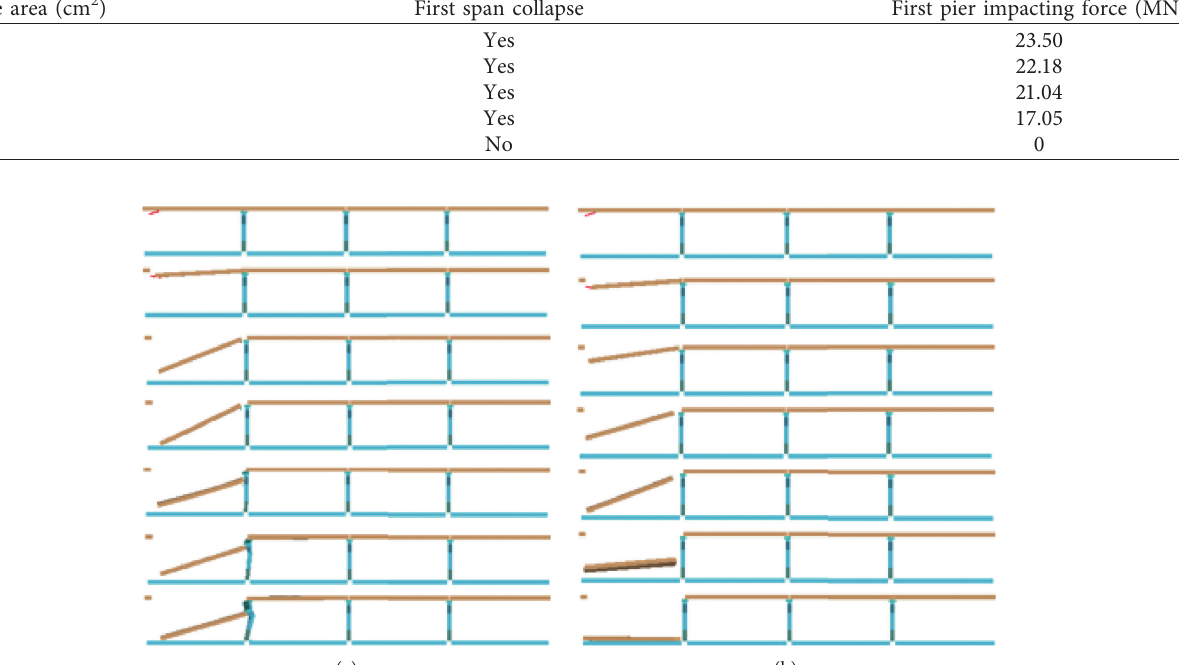
Figure 21: Collapse procedure of Hongqi 4-span bridge equipped with restrainers: (a) with inadequate cross-sectional area and (b) with adequate cross-sectional